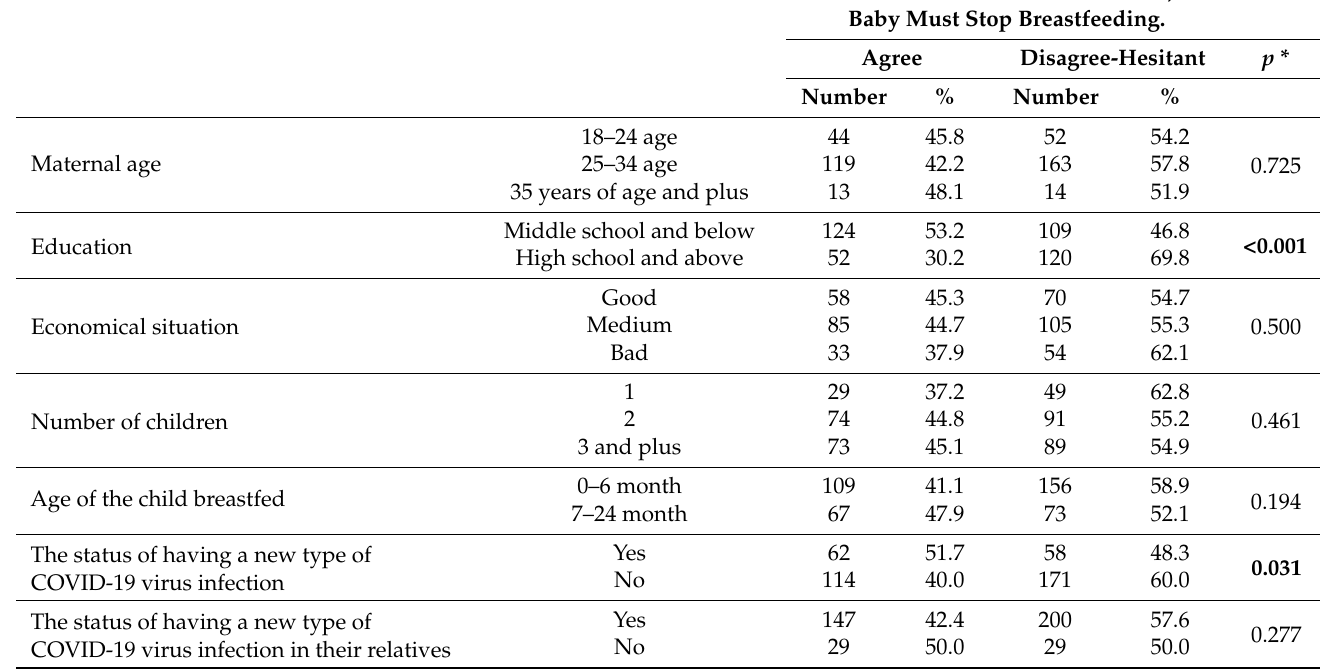
Table 4. According to the descriptive characteristics of the mothers participating in the study, the proportions of mothers who think that their baby should stop breastfeeding to be vaccinated against